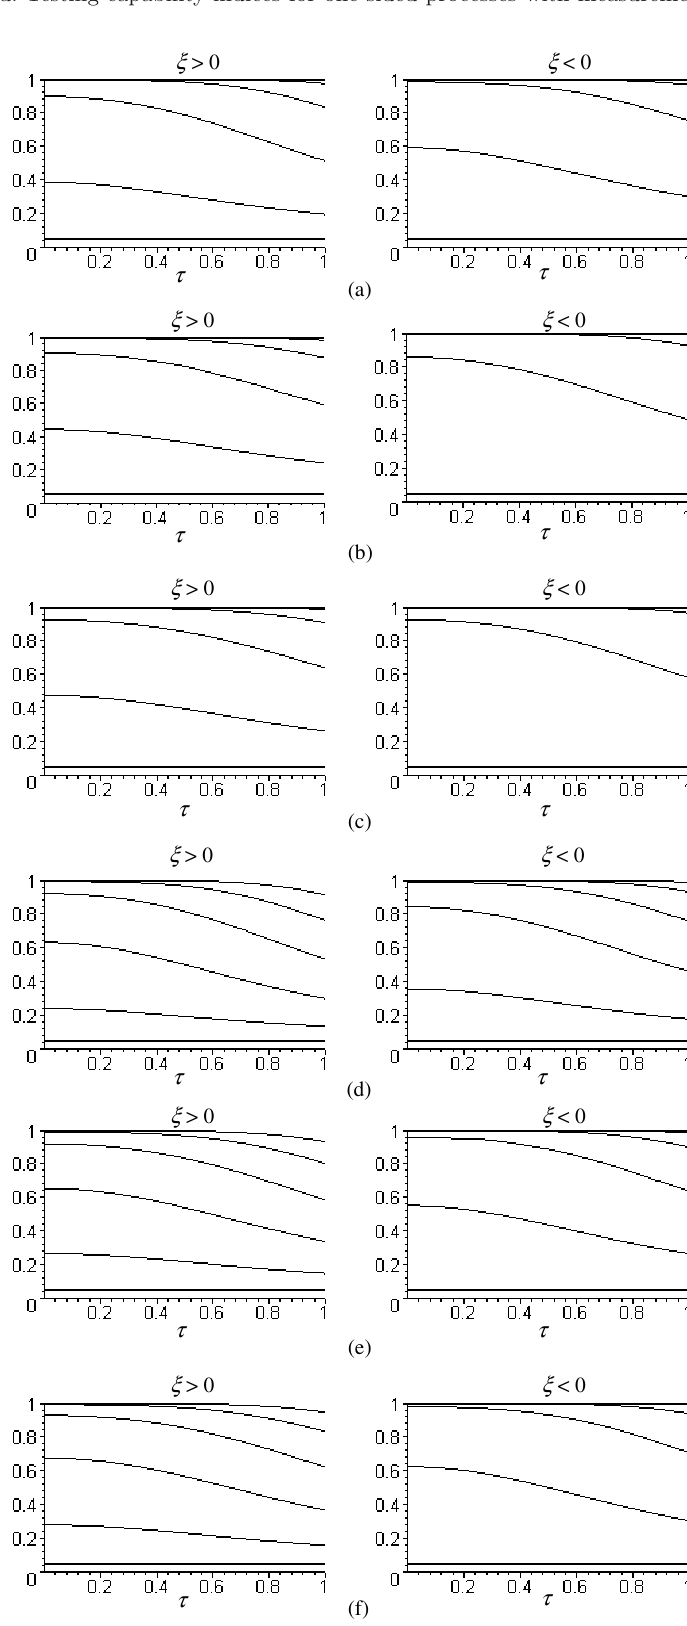
C u u, v )+0 . 33; (c) c = 1 and C u p = p (